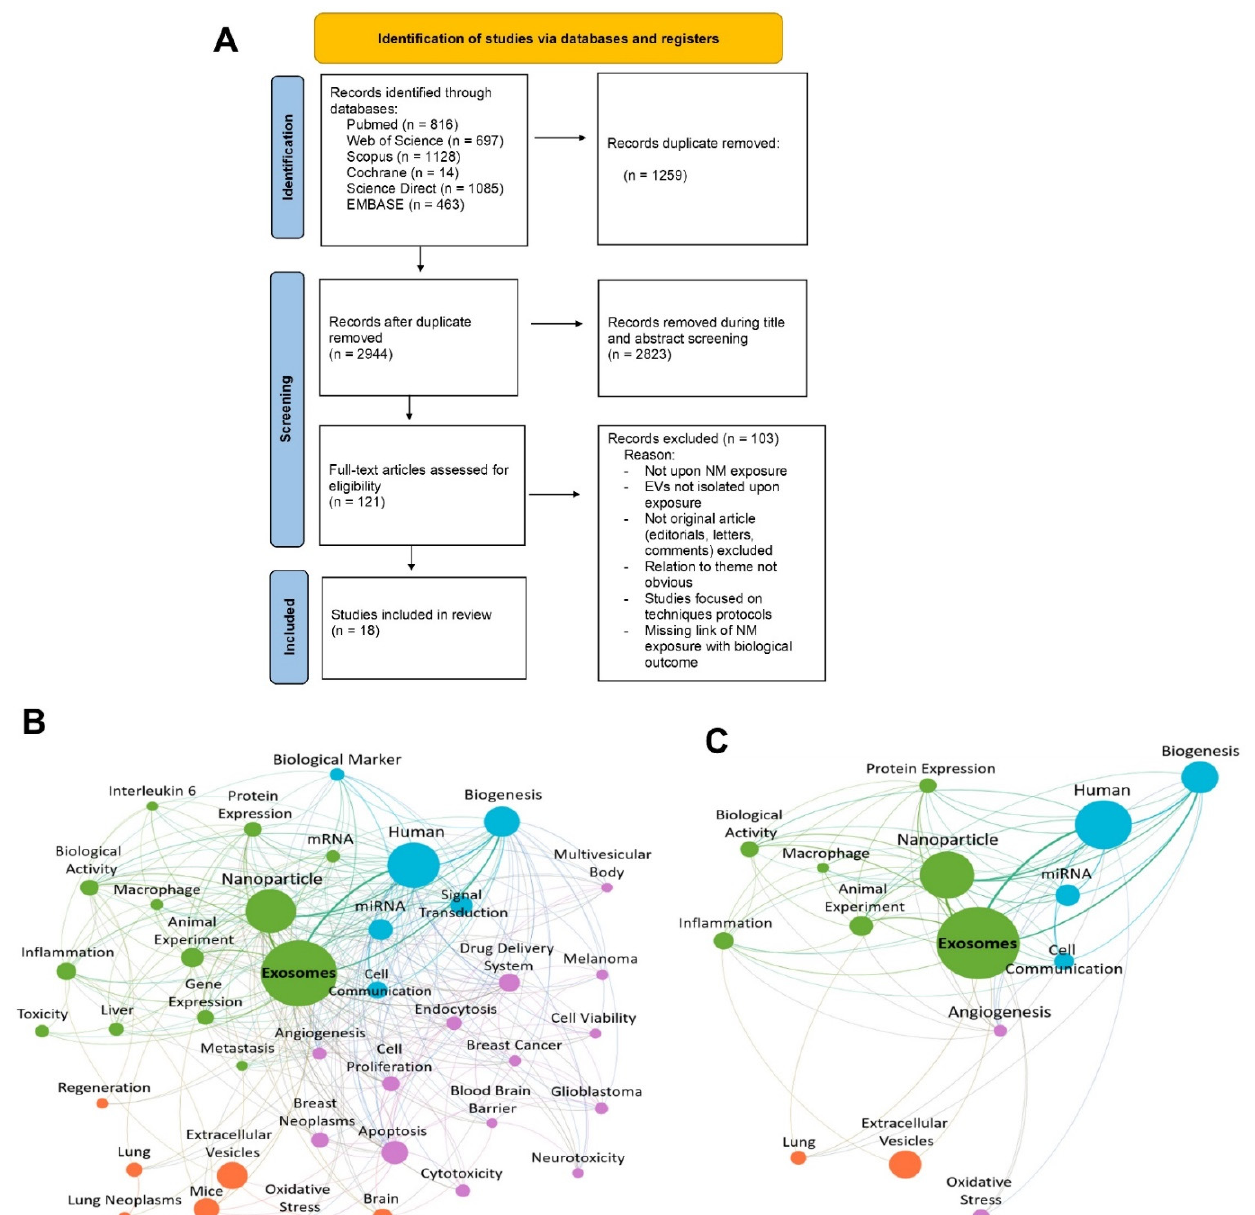
Figure 1. ( A ) PRISMA flow diagram applied in this ScR, co-occurrence network of the most fre- quently used keywords in the ( B ) 2944 unique results and ( C ) 18 ultimately selected articles. Each color suggests a set of keywords shared among the analyzed